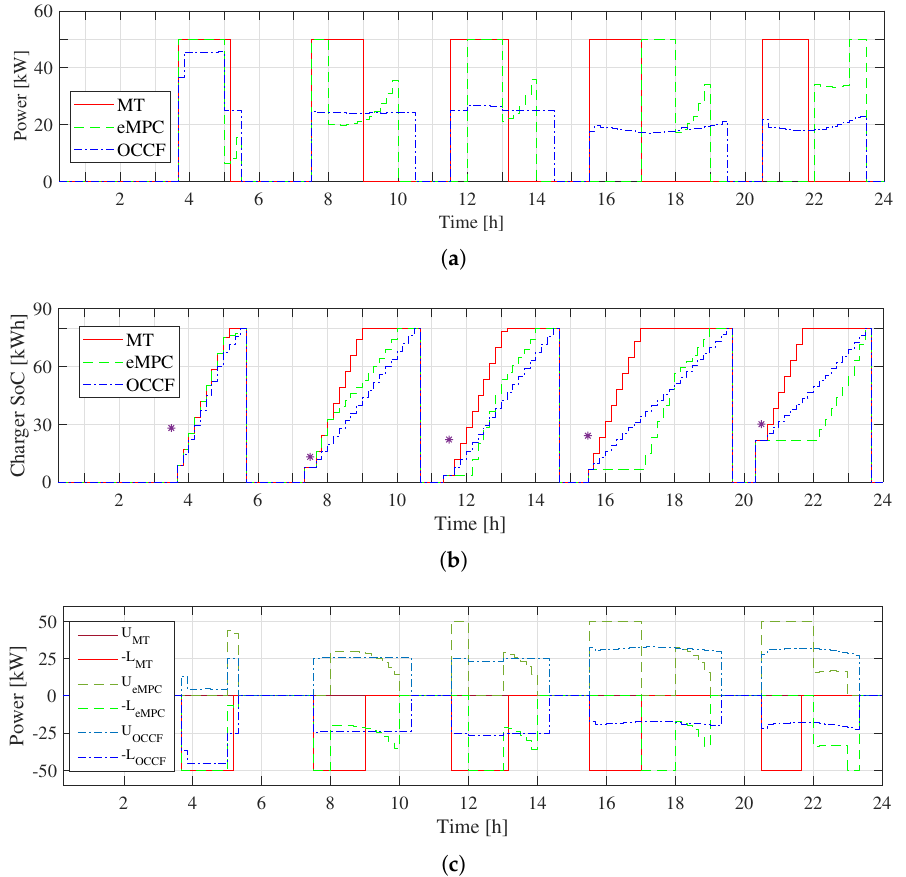
Figure 7. The behaviour of the three charging strategies in charger 1, with arrival SoC and time uncertainties. ( a ) Power profiles P 1, k with the different strategies. ( b ) Charger SoC x 1, k with the different strategies. ( c ) Flexibility capacity provided by charger